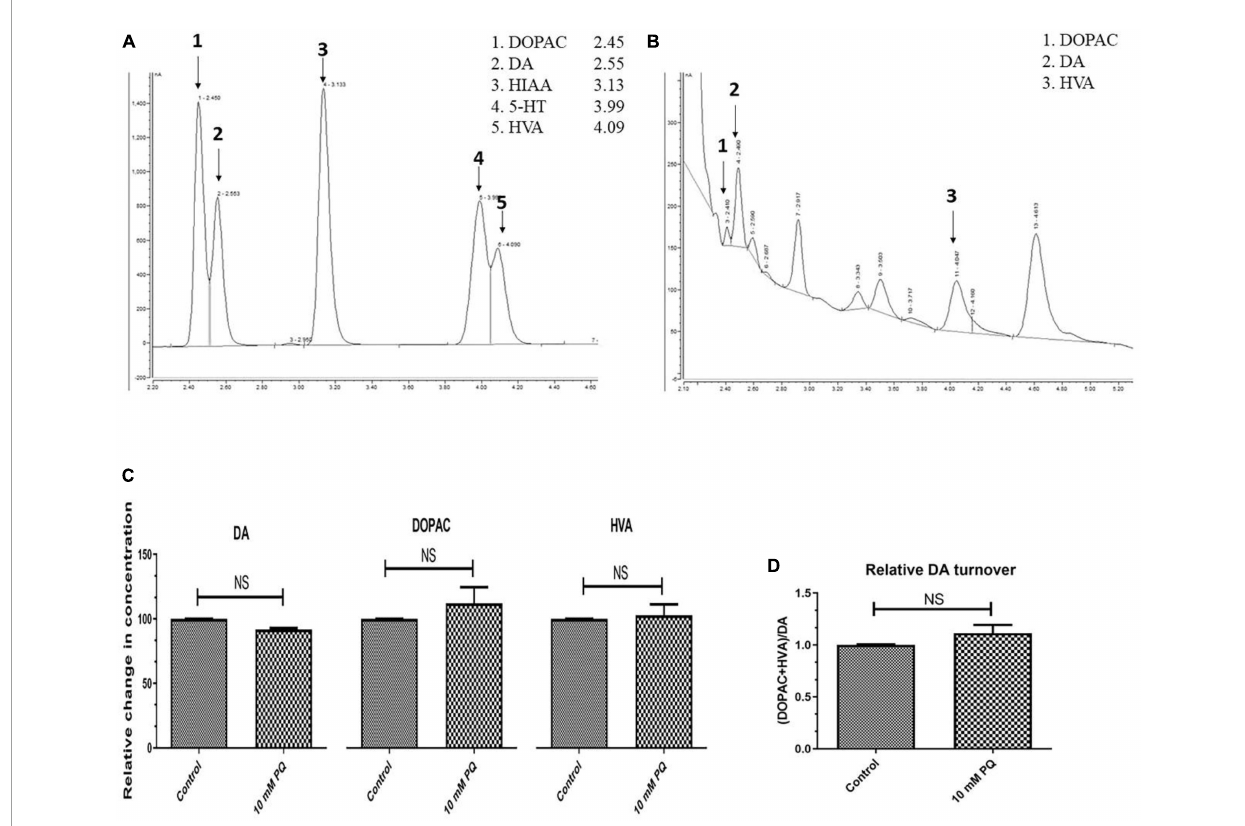
FIGURE4 Quantification Dopamine (DA) and its metabolites- 3,4-Dihydroxyphenyl acetic acid (DOPAC) and Homovanillic acid (HVA) using High-Performance Liquid Chromatography (HPLC) in fly brain homogenate: The retention time of standard DA, DOPAC, and HVA is shown in the chromatogram (A) and chromatogram for the fly brain homogenate shows the detected monoamines (B) . The relative level of DA and its metabolites (DOPAC and HVA) shows that there is no significant difference between the control and PQ-treated groups (C) . Results also revealed that in PQ treated group compared to the control, there is no alteration of DA catabolism to DOPAC and HVA, as represented by unaltered relative DA turnover (D) . Statistical analysis was performed using a t -test (compared to the control), NS,